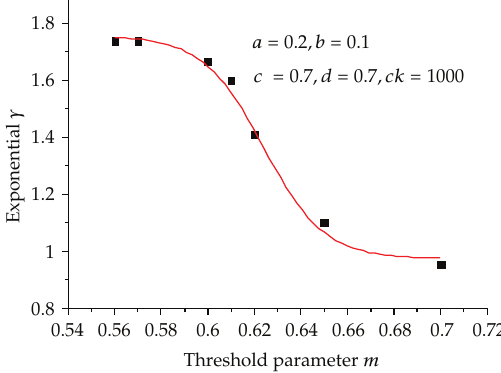
Figure 5: E ff ect of parameter m on power exponent γ